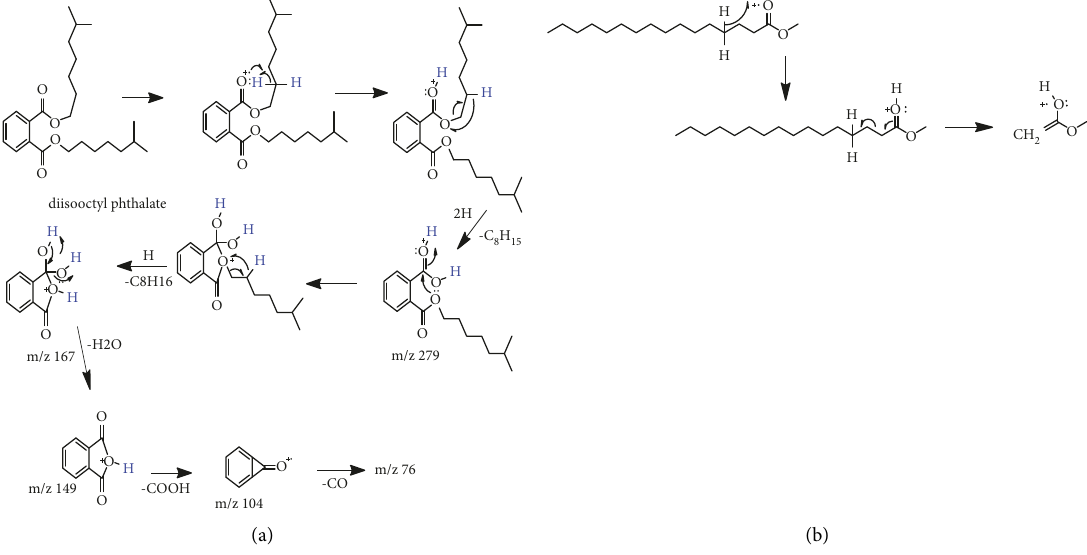
diisooctyl phthalate